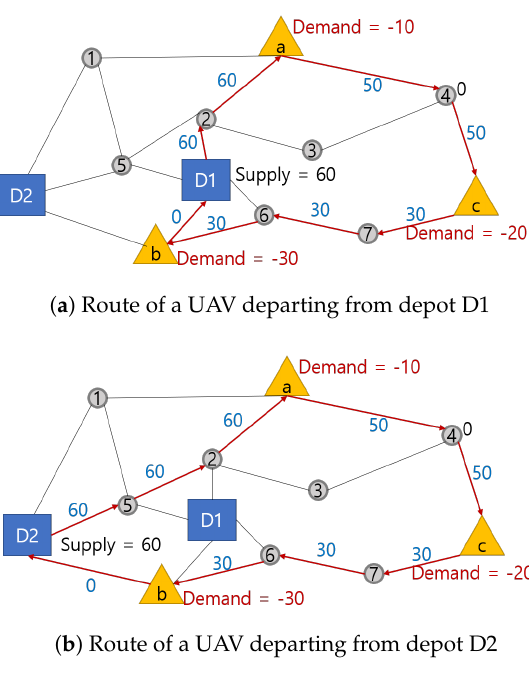
Figure 4. Routes of UAVs from depot D1 and